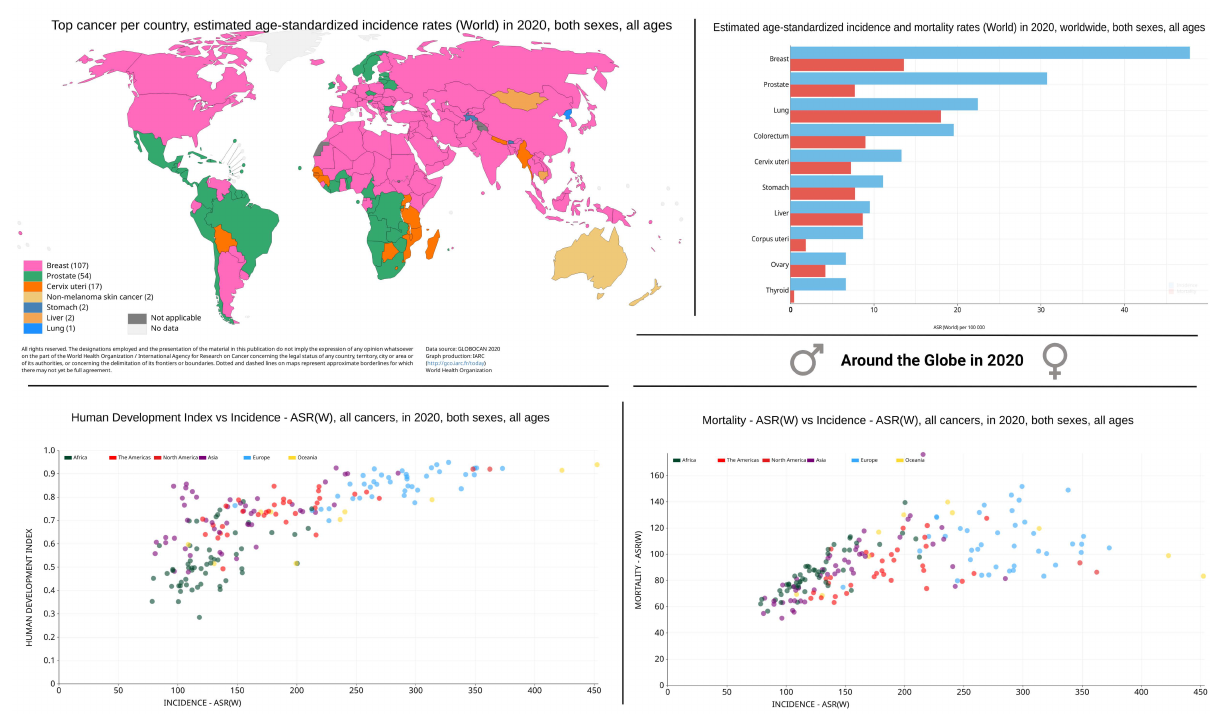
Figure 1. A snapshot of worldwide cancer incidence and mortality: Representation of the major cancer types (color coded) in each country based on the age standardized incidence rates for all ages and sex (world map). On the right, the bar graph represents the age standardized rates (ASR) based estimates on incidence and mortality, accounting for all ages for both male and female combined. Bottom left dot plot represents the ASR estimates on the world human development index (HDI)